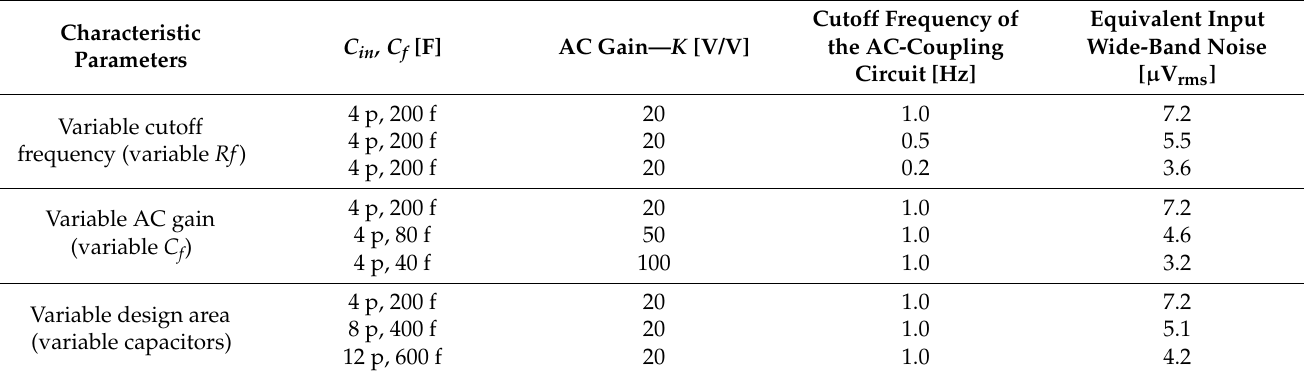
Table 1. Input-referred noise rms for various parameters of the circuit. The rms values are calculated in 1 Hz–10 kHz frequency range. Assumptions: C ina = C inb = C in , C fa = C fb = C f , R fa = R fb = R f